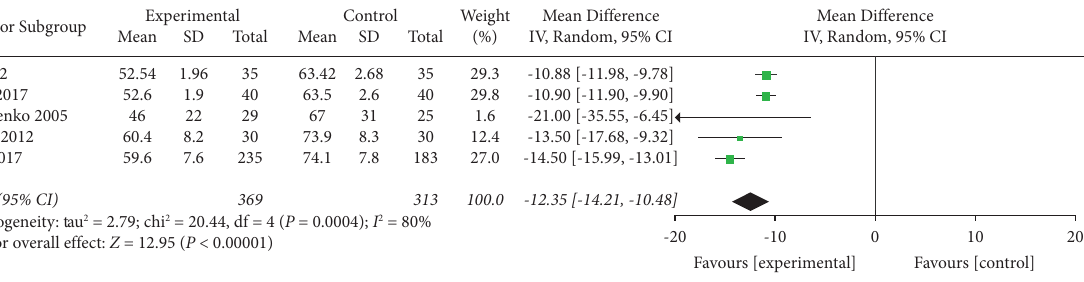
Figure 10: Comparison of the amount of analgesics used between the AA group and the control group.